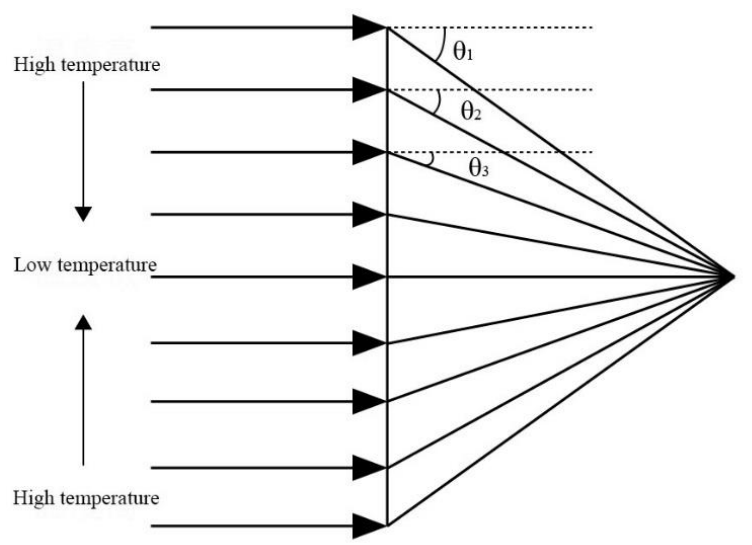
Figure 1. Schematic diagram of temperature-controlled focusing principle. It can be seen from Figure 1 that the high-temperature area has a large acoustic wave transmission angle, a smaller phase delay, and a larger speed of sound, but the acoustic wave travels farther. The low-temperature area has a smaller acoustic wave transmission angle, a greater phase delay, and a slower speed of sound, but the distance is relatively short; thus, the acoustic waves eventually arrive at the same point in the same phase to form an acoustic wave